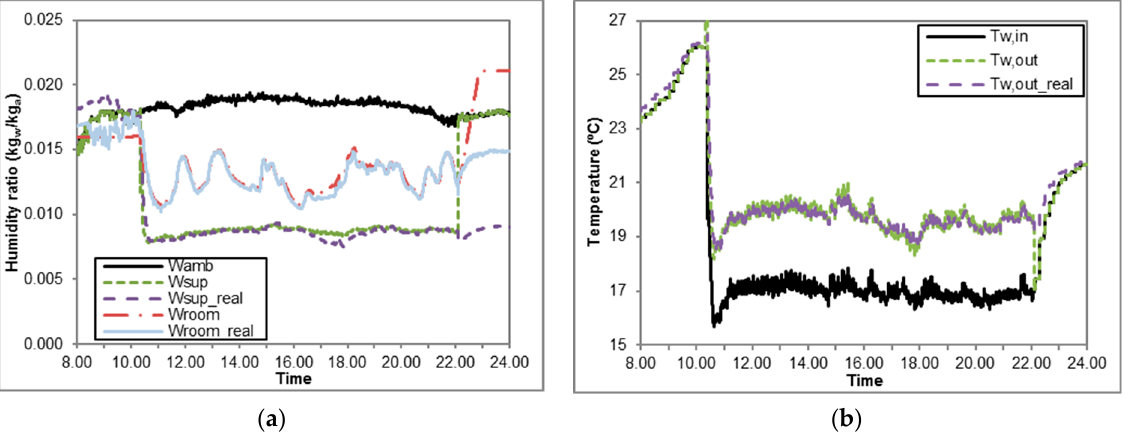
Table 5. Statistical comparison between measured and simulated data of some parameters of the system. Statistical Parameter